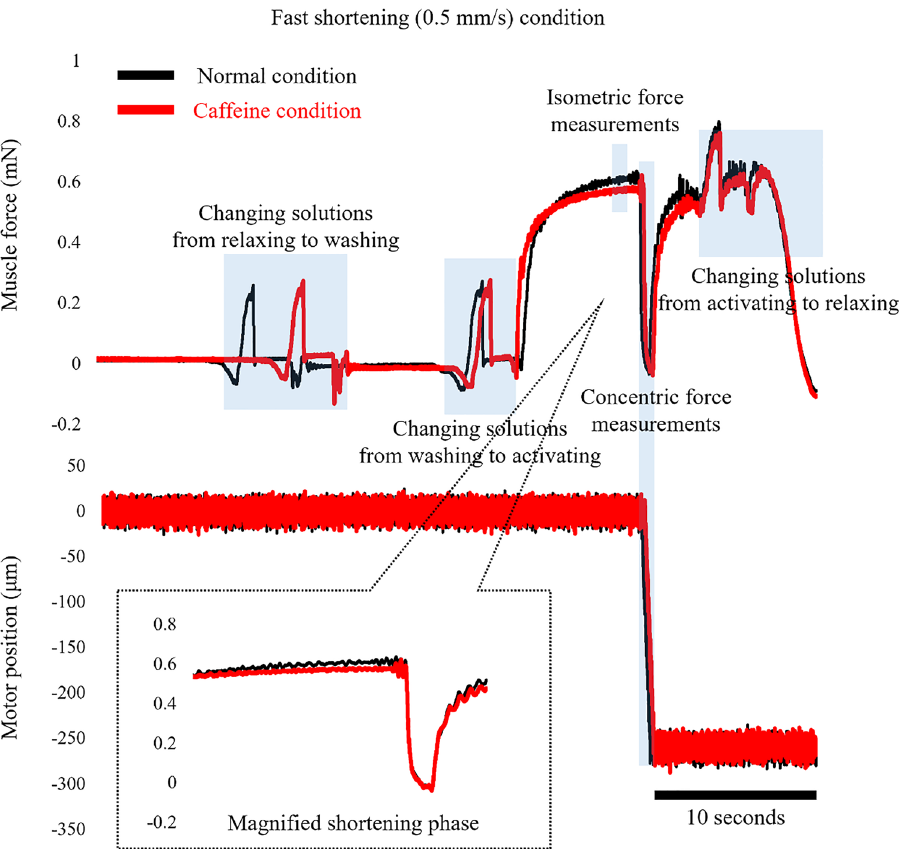
Figure 2. Force and length responses for the normal and caffeine conditions in the fast shortening trials. Black lines indicate the normal condition and red lines indicate the caffeine condition. The inset shows the magnified force responses during the shortening